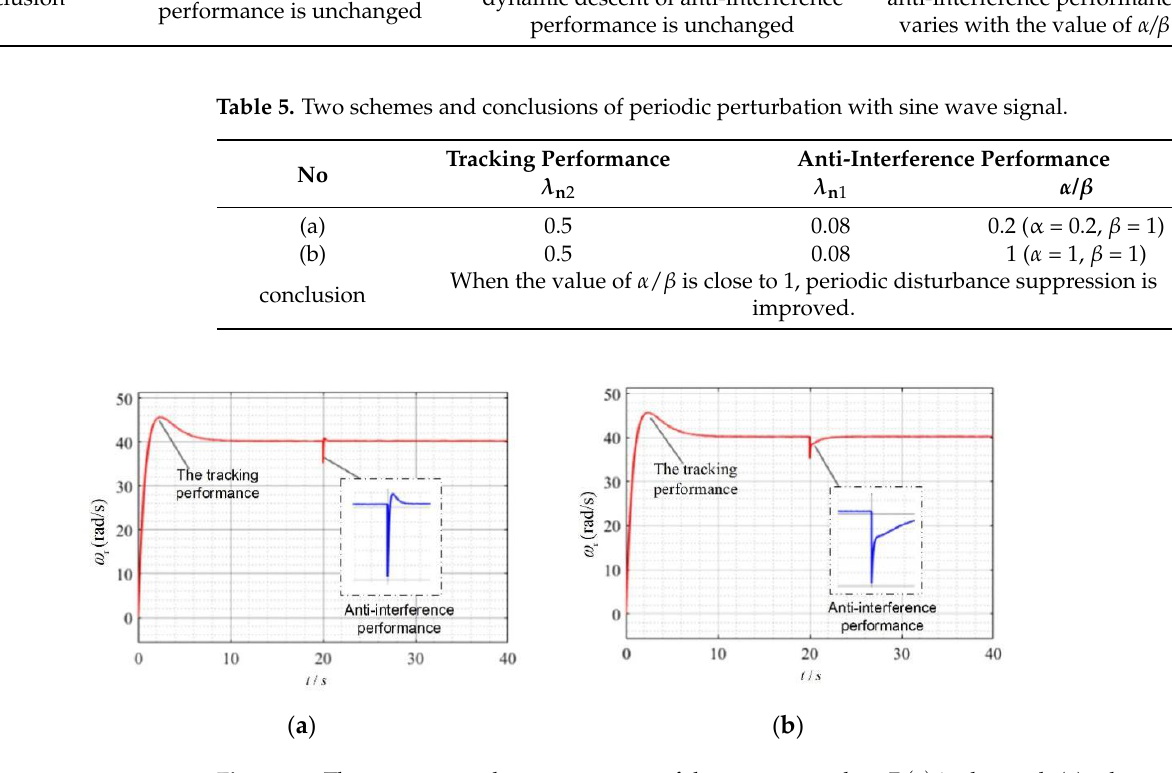
Figure 16. The output speed response curve of the generator when 𝐹 f (𝑠) is changed: ( a ) scheme (a); ( b ) scheme (b). ( b ) scheme